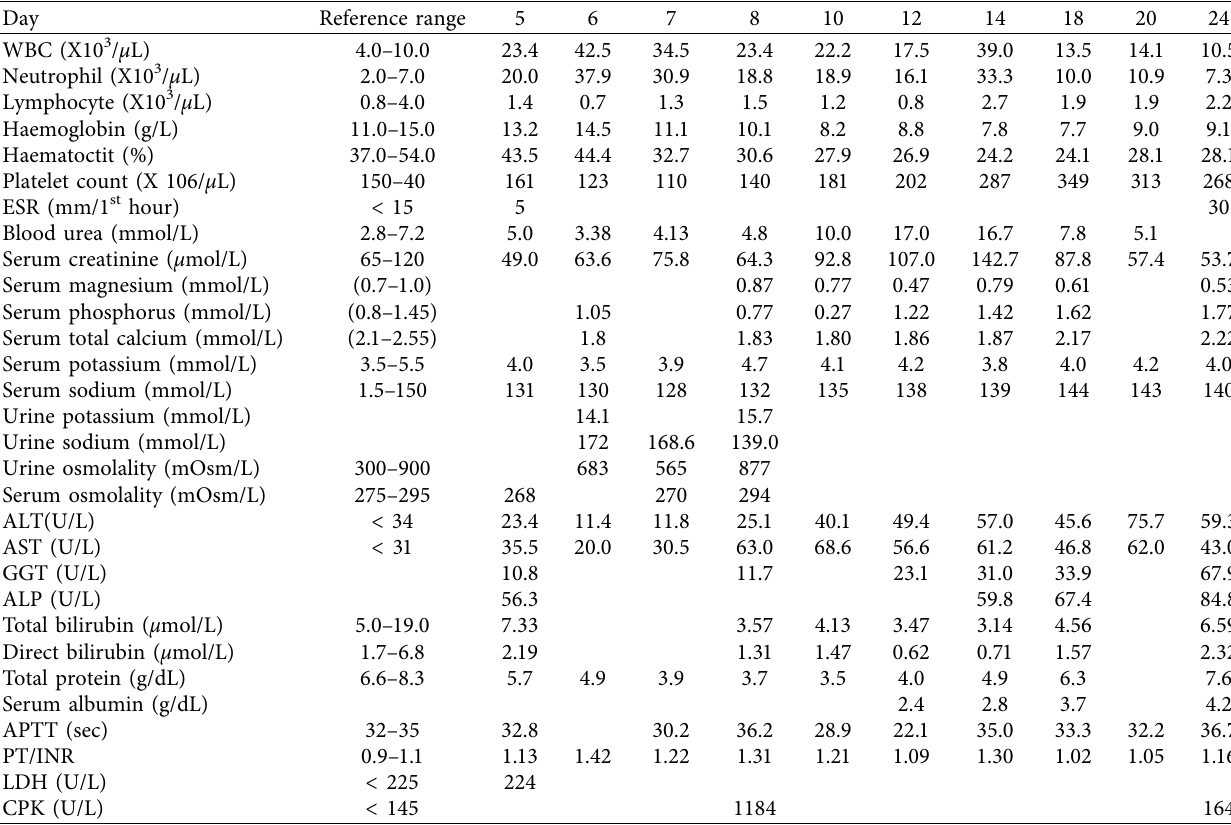
Table 1: Trend of blood or serum biochemical parameters.